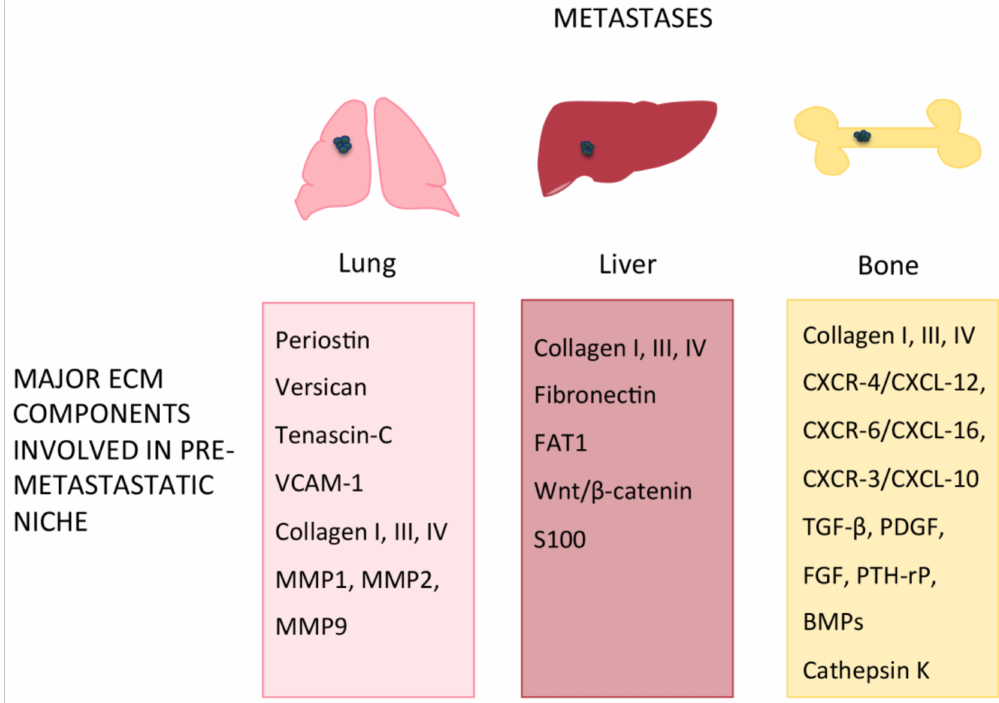
Figure 2. ECM components involved in pre-metastatic niche formation in lung, liver and